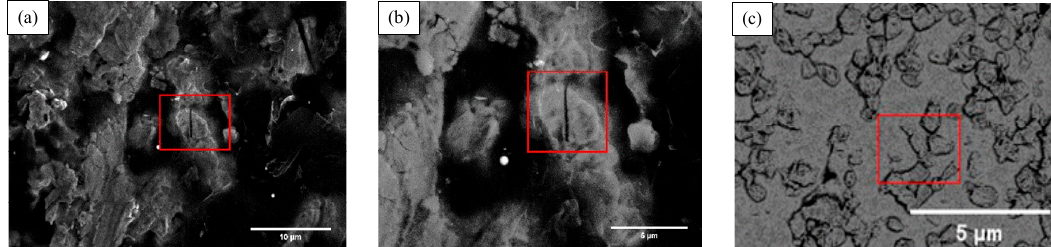
Figure 5. Crack induced in the fracture surface of Mo–3Si–1B–1Zr–1Y 2 O 3 alloy: ( a ) SEM image 3000 × magnification; ( b ) SEM image 6000 × magnification; ( c ) crack propagation via intermetallic phases and crack arrest in an α -Mo phase.